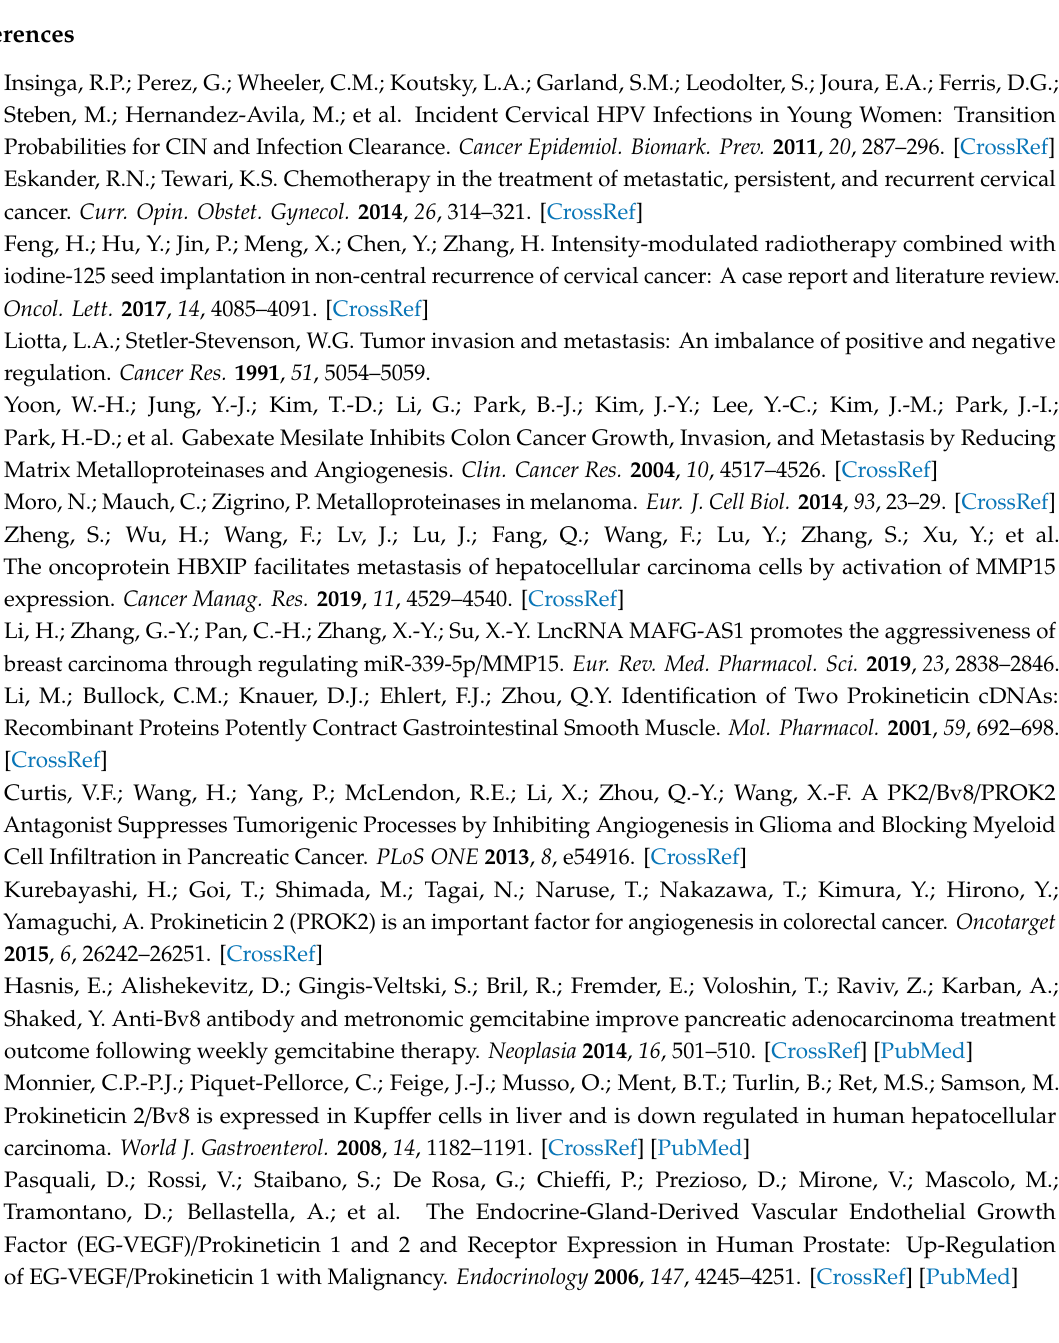
e ff ect of cervical cancer. PROK2 might acts as a potential predictor and molecular target for cervical cancer